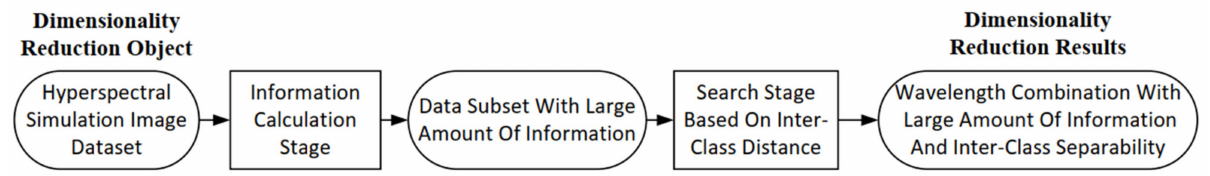
Figure 2. LBI-BPSO wavelength selection